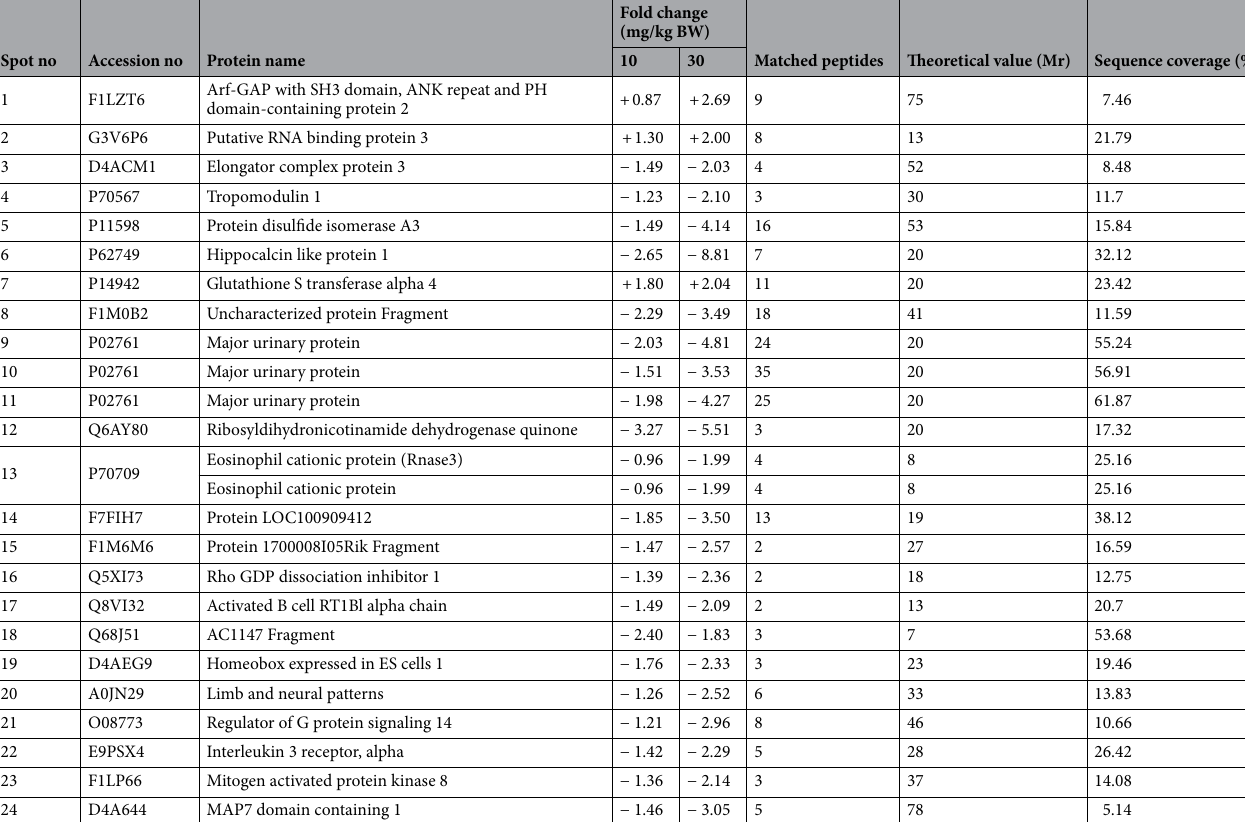
Table 3. UPLC-ESI-MS E identification of dose-dependent protein spots in the kidney tissue protein of rats administrated